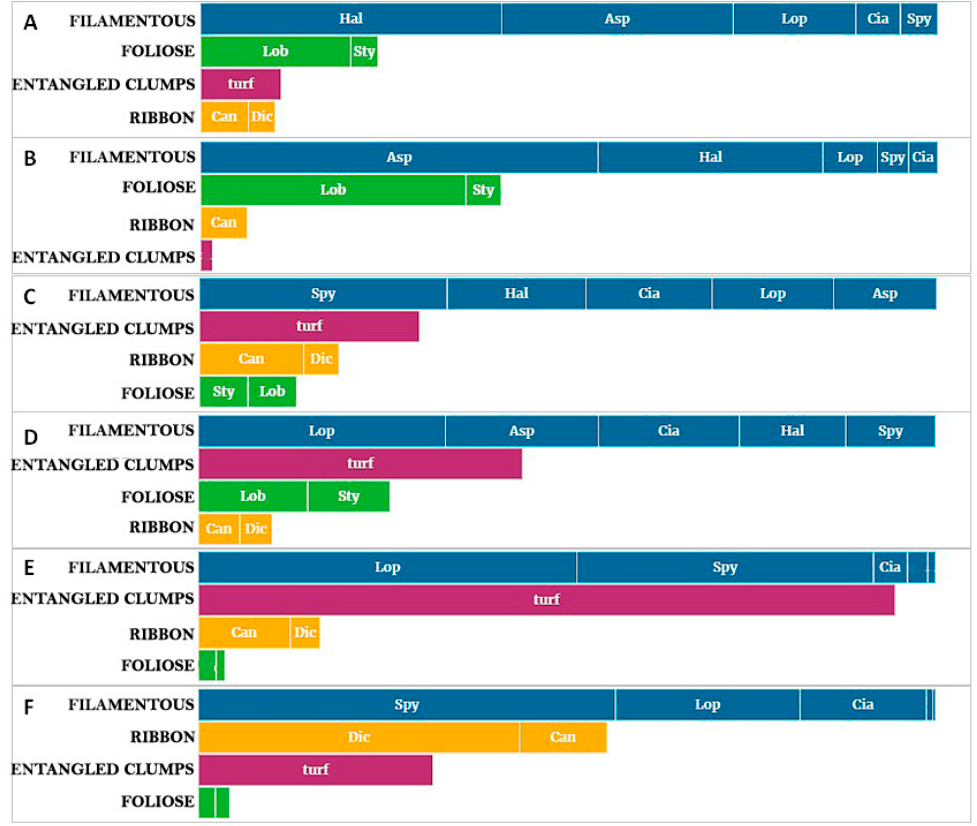
Figure 4. Relativeabundancesofdinoflagellategenera: Gambierdiscus ( A ), Sinophysis ( B ), Prorocentrum ( C ), Figure 4. Relative abundances of dinoflagellate genera: Gambierdiscus ( A ), Sinophysis ( B ), Coolia ( D ), Ostreopsis ( E ), Vulcanodinium ( F ) in di ff erent types of macrophytes according the thallus Prorocentrum ( C ), Coolia ( D ), Ostreopsis ( E ), Vulcanodinium ( F ) in different types of macrophytes structure (see Section 2.3). See macrophyte codes in Table according the thallus structure (see Section 2.3). See macrophyte codes in Table 1.